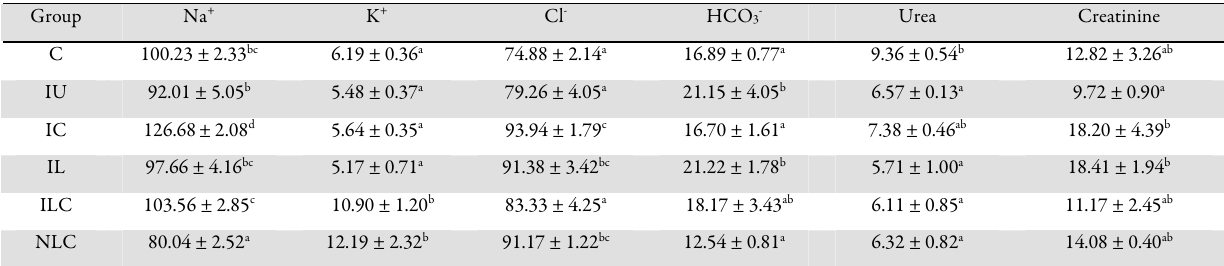
Table 7. The effect of lumefantrine and lumefantrine - copper complex on the concentration of some biochemical parameters in the plasma of P. berghei NK- 65 infected mice